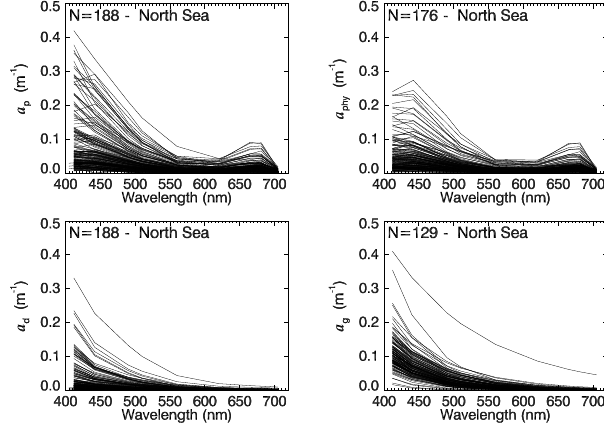
Figure 12. The match-up field absorption spectra provided from the North Sea site.